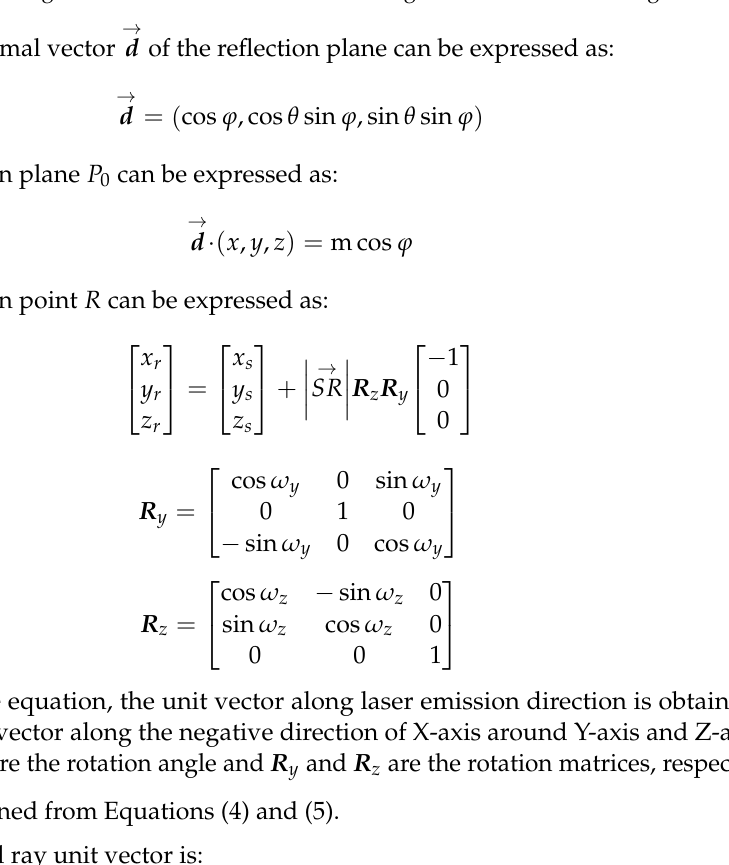
Figure 3. Schematic diagram of coordinate calculation of single-sided mirror scanning model.